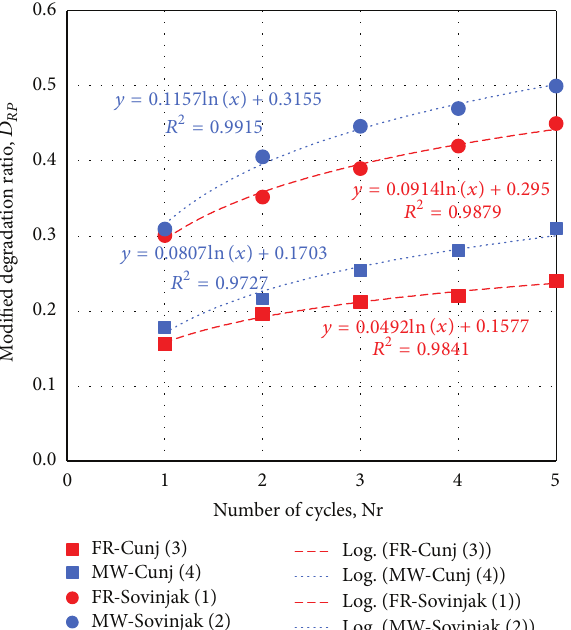
Figure 12: Logarithmic curves fitted to the plot of the modified degradation ratio against slake durability test cycles for the siltstone samples of weathering grades I (FR) and III (MW) from the flysch outcrops near Cunj Village and Sovinjak